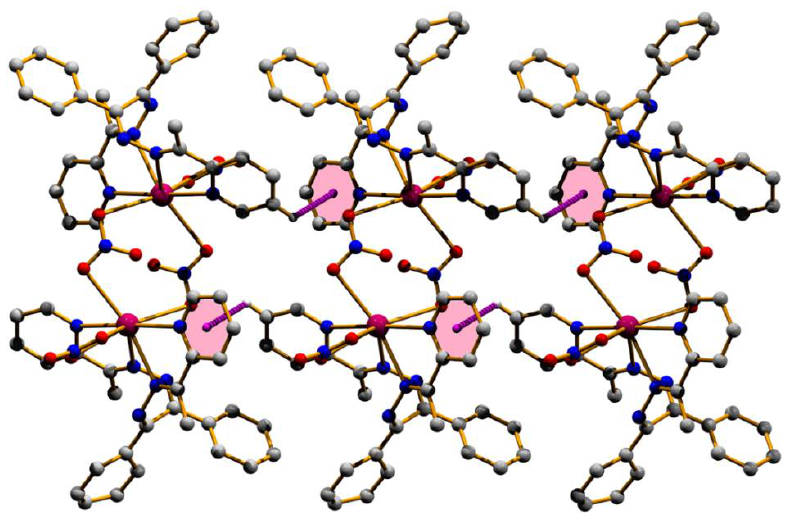
Figure 7. Perspective view of the supramolecular network through C‒H∙∙∙π interactions in ( 2 ).